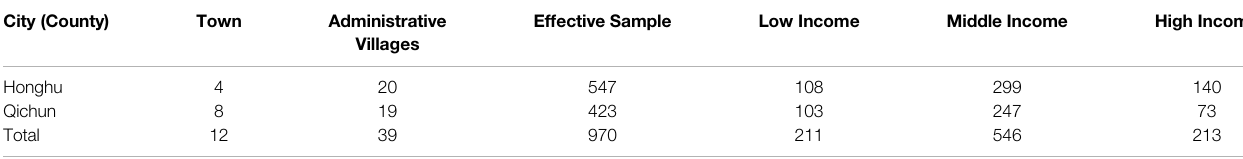
TABLE 1 | Sample distribution.